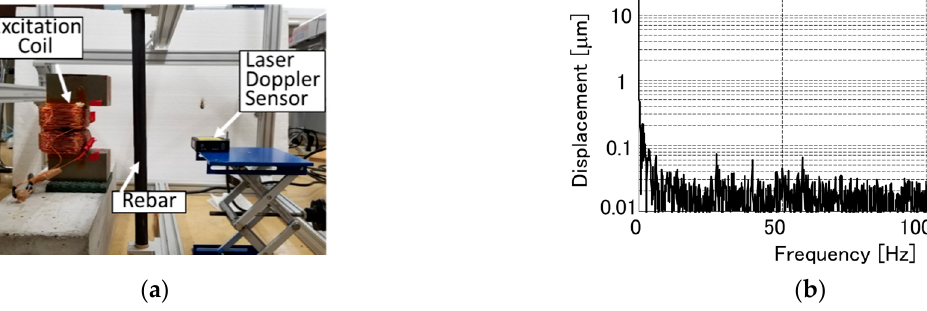
Figure 4. Rebar vibration characteristics in air: ( a ) Measurement setup; ( b ) Displacement spectrum obtained by a laser displacement sensor (LDS). Table 1. Vibration displacement measured in air by LDS.